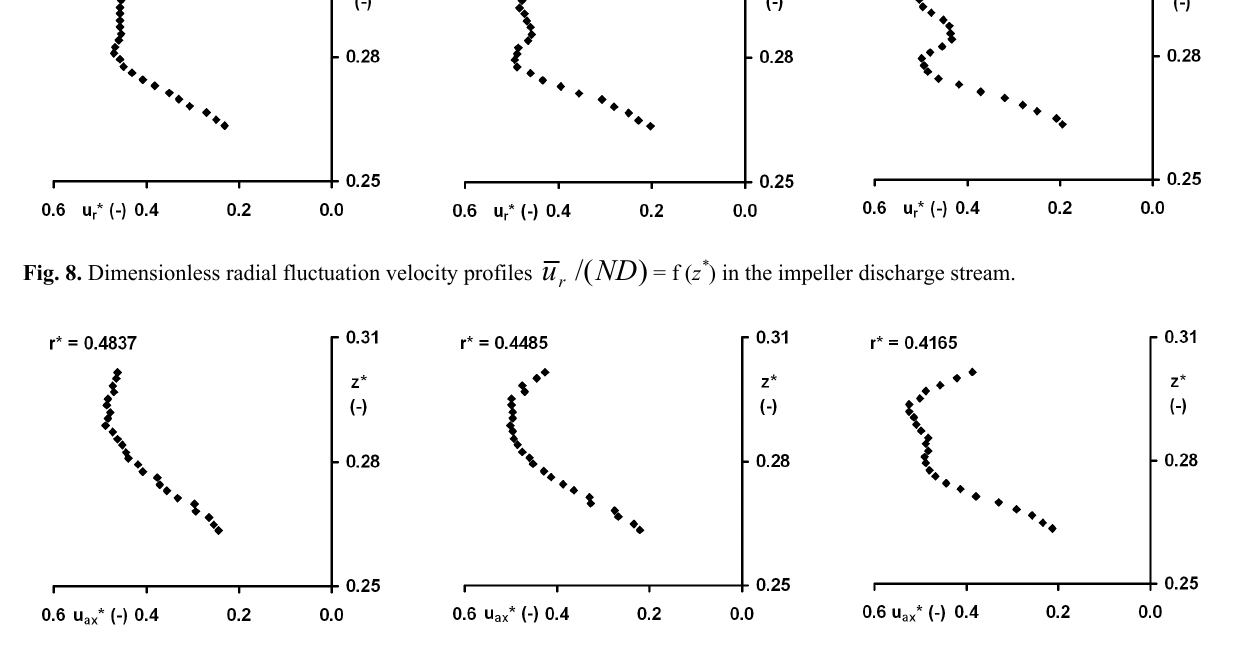
Fig. 9. Dimensionless axial fluctuation velocity profiles )/( NDu